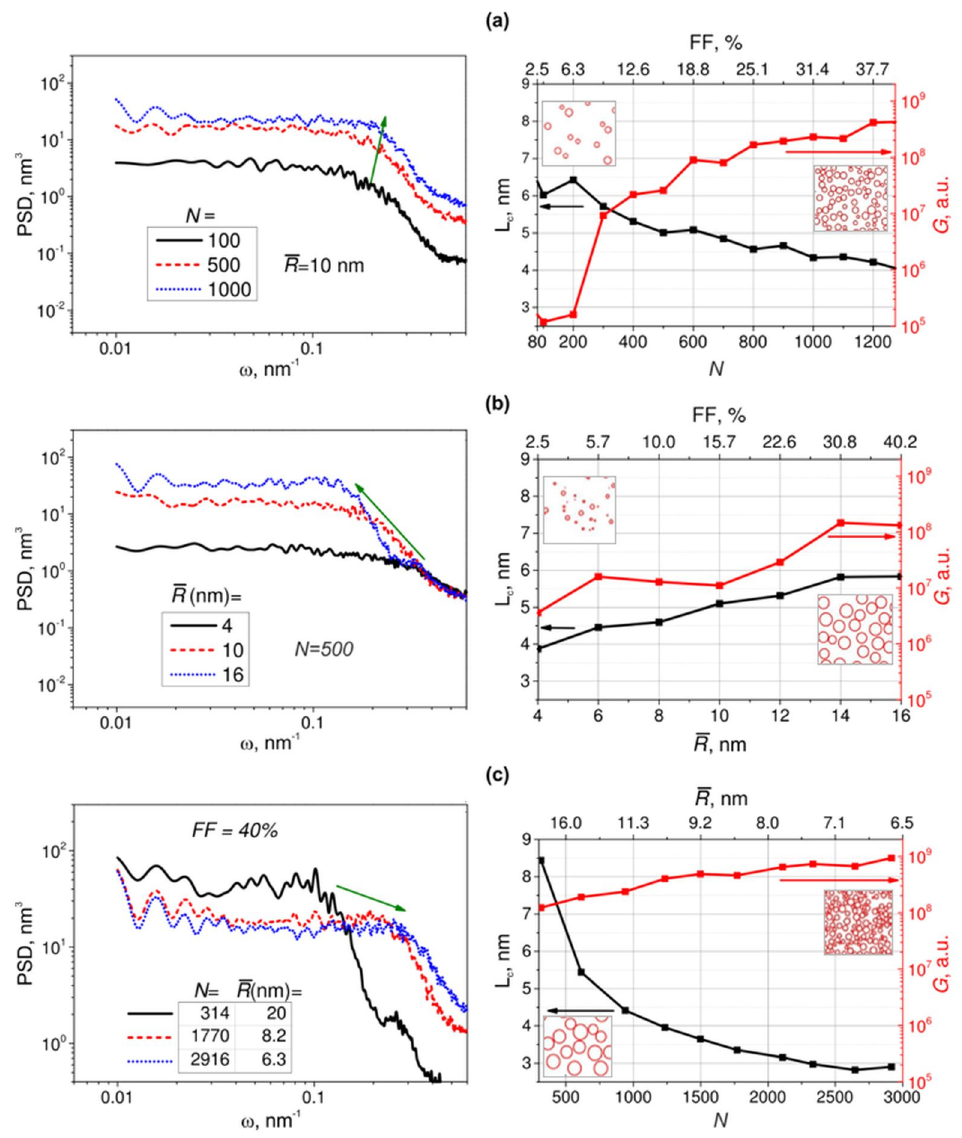
Figure 4. Modeled PSD functions (left column) and dependencies of the correlation length (left axis, black curve) and Raman signal (right axis, red curve) (right column) for the ensembles of particles with: ( a ) variable number and the same average radius of particles, R = 10 nm (insets: simulated random spatial arrangements of N = 100 and N = 1000 particles); ( b ) variable average radius and the same number of particles, N = 500 (insets: simulated random spatial arrangements for the ensembles with R = 4 nm and 16 nm); ( c ) variable number and average radius of particles, but with the same fill factor, 40% (insets: simulated random spatial arrangement of N = 314 particles with R = 20 nm and N = 2916 particles with R = 6.3 nm). In all the computations, the surface area is 1 × 1 µ m 2 , the nanoparticles have log-normal radius distributions, and the radius dispersion is 2